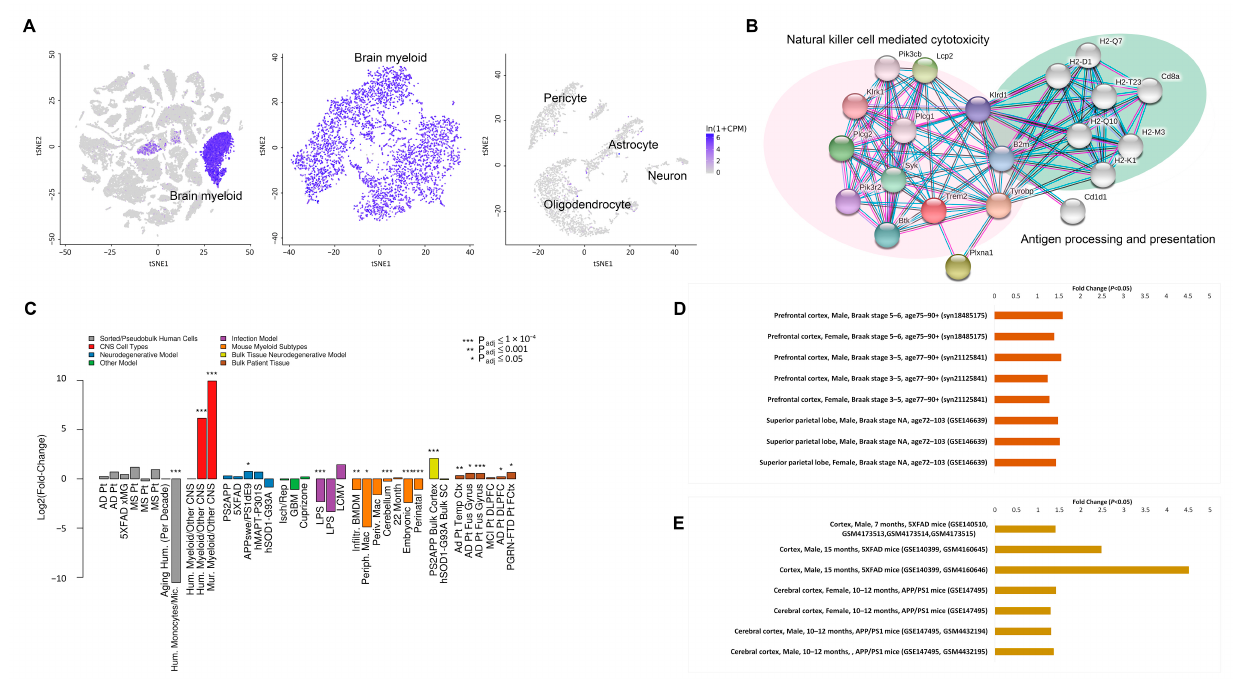
Figure 1. Trem2 / TREM2 expression patterns in Alzheimer’s disease (AD) mouse models and AD postmortem samples. ( A ) Trem2 gene expression in 3-month-old Mus musculus C57BL/6 brain myeloid cells. The scRNAseq data were acquired from Tabula Muris [30]. ( B ) Protein interaction network of Trem2 in Mus musculus innate immunity. The self-learning interaction network was generated by STRING [31]. ( C ) Trem2 / TREM2 upregulations in multiple AD animal models and AD postmortem samples. Metadata were acquired from The Myeloid Landscape 2 [44]. ( D ) TREM2 upregulations in AD postmortem samples ( p < 0.05). The snRNAseq gene expression data were acquired from scREAD [45]. ( E ) Trem2 upregulations in microglia of 5XFAD and APP/PS1 AD mouse models ( p < 0.05). The snRNAseq gene expression data were acquired from scREAD